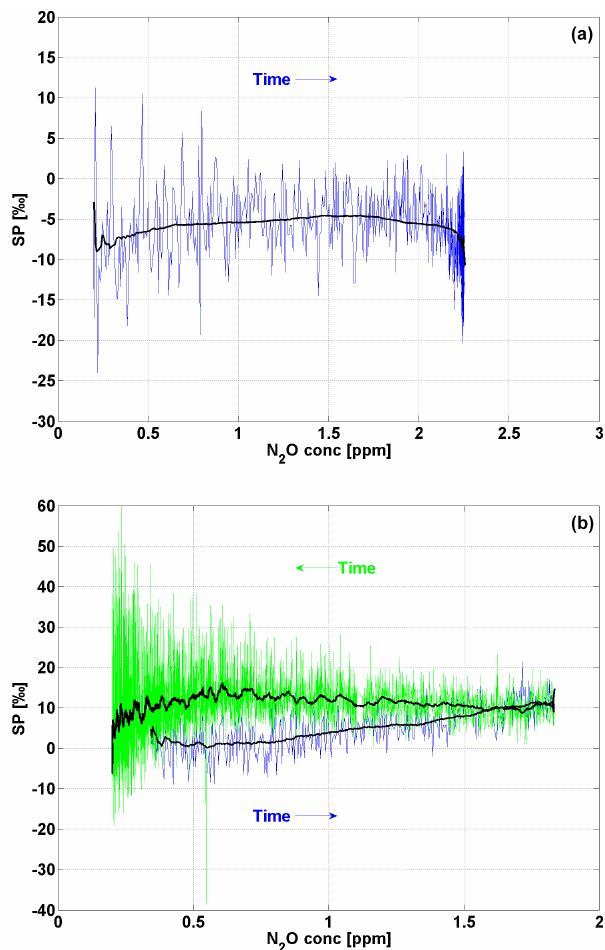
Figure 5. (a) δ 15 N α as a function of N 2 O concentration as pro- duced by P. chlororaphis and the modeled Rayleigh-type distilla- tion. High-resolution CRDS data (blue line) and 5min running av- erage (black line). The red curve is the modeled Rayleigh-type dis- tillation curve for the production of N 2 O. The blue arrow indicates the direction of time during production of N 2 O. (b) δ 15 N β as a function of N 2 O concentration as produced by P. chlororaphis and the modeled Rayleigh-type distillation. High-resolution CRDS data (blue line) and 5min running average (black line). The red curve is the modeled Rayleigh-type distillation curve for the production of N 2 O. The blue arrow indicates the direction of time during produc- tion of N 2